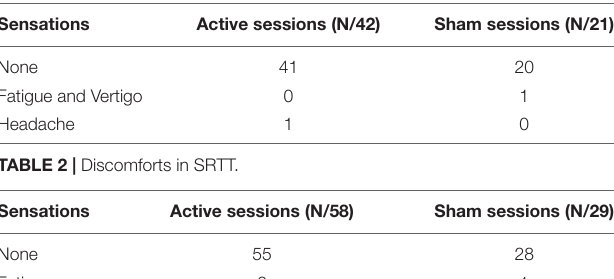
TABLE 1 | Discomforts in RRTT.